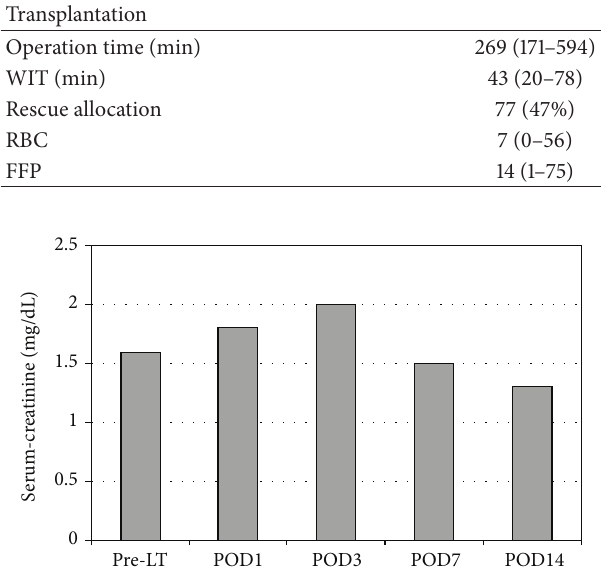
Figure 1: Postoperative creatinine